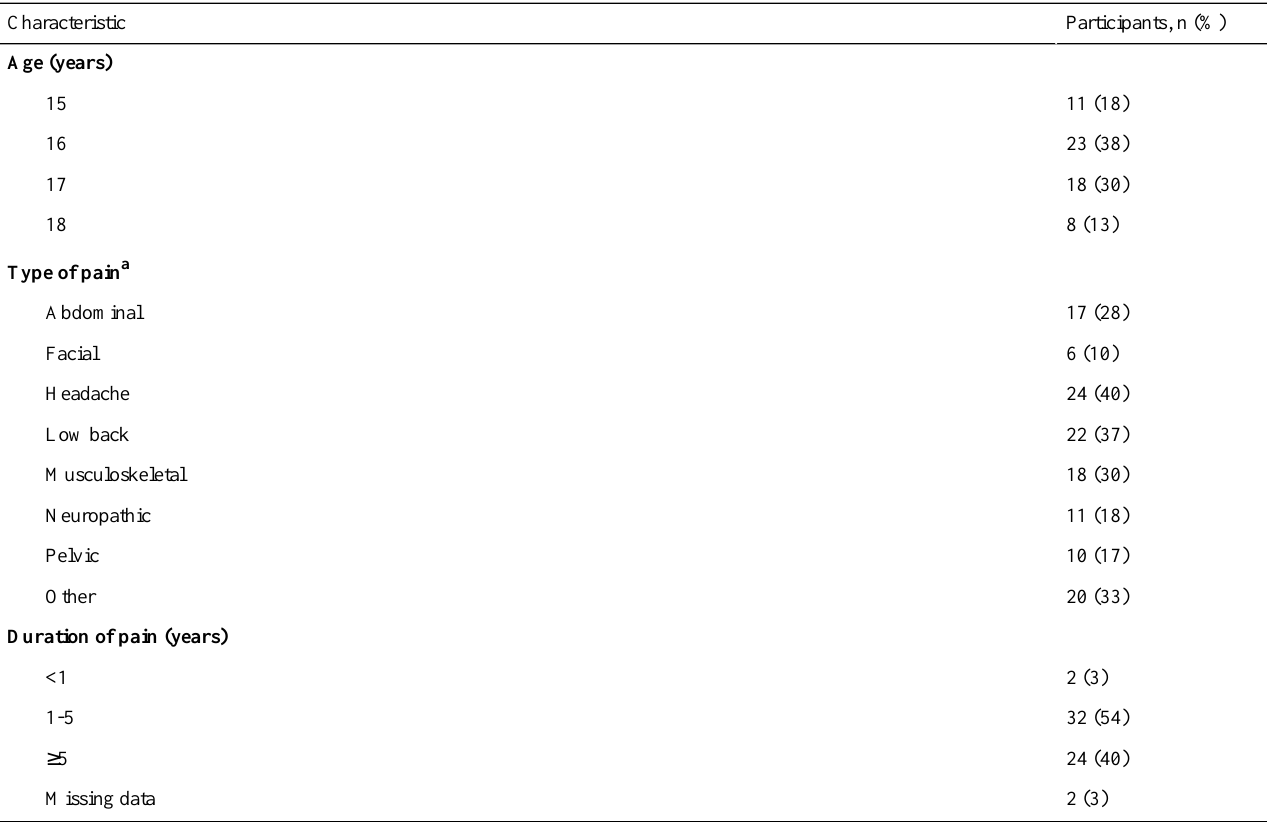
Table 1. Demographic and chronic pain characteristics of the study sample